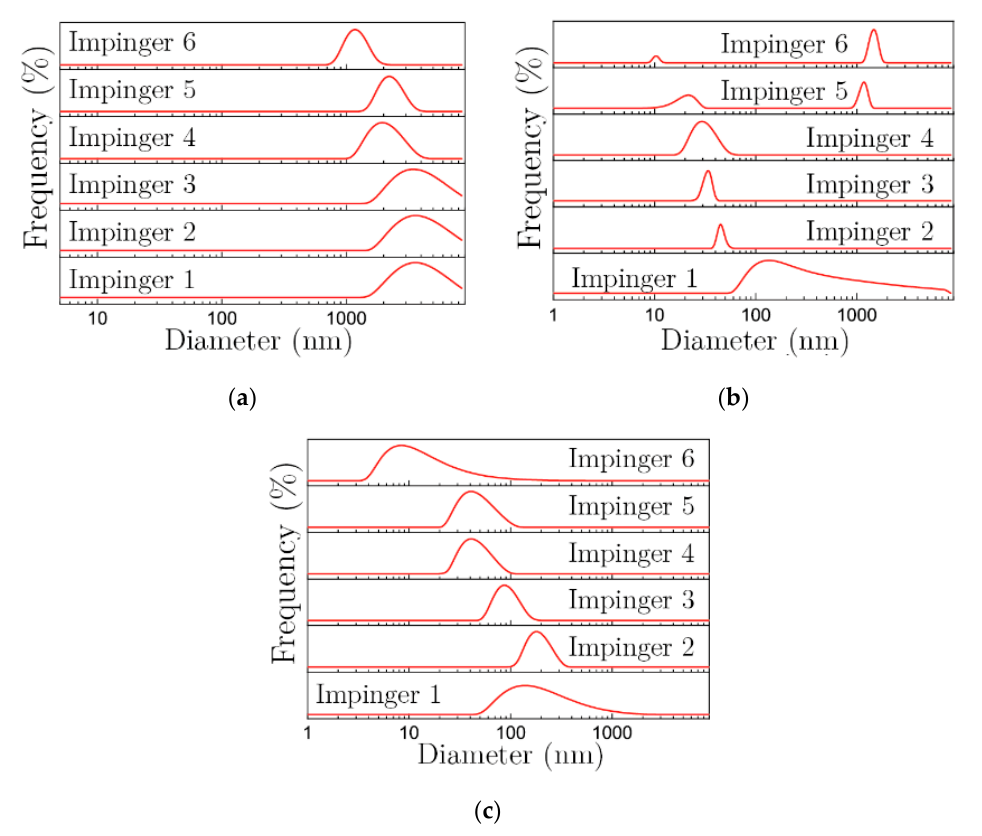
Figure 4. The effect of different plasma powers. ( a ) 0 Watts, ( b ) 42 Watts, and ( c ) 85 Watts on the particle size distribution of tar (0 W) and BCFM (42 and 85 W) in impinger 1–6.